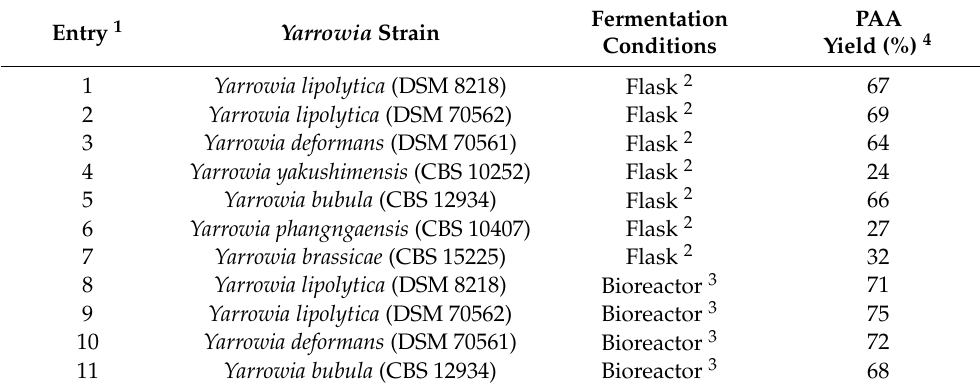
Table 4. Synthesis of PAA acid by biotransformation of (L)-phenylalanine using different Yarrowia